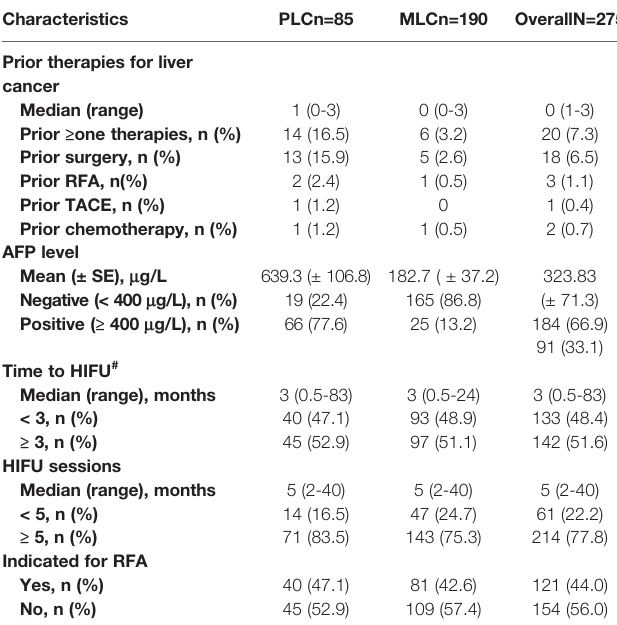
*LDisforthepatientswithmultiplelesionswerethesumofthelongestdiameterofallthese